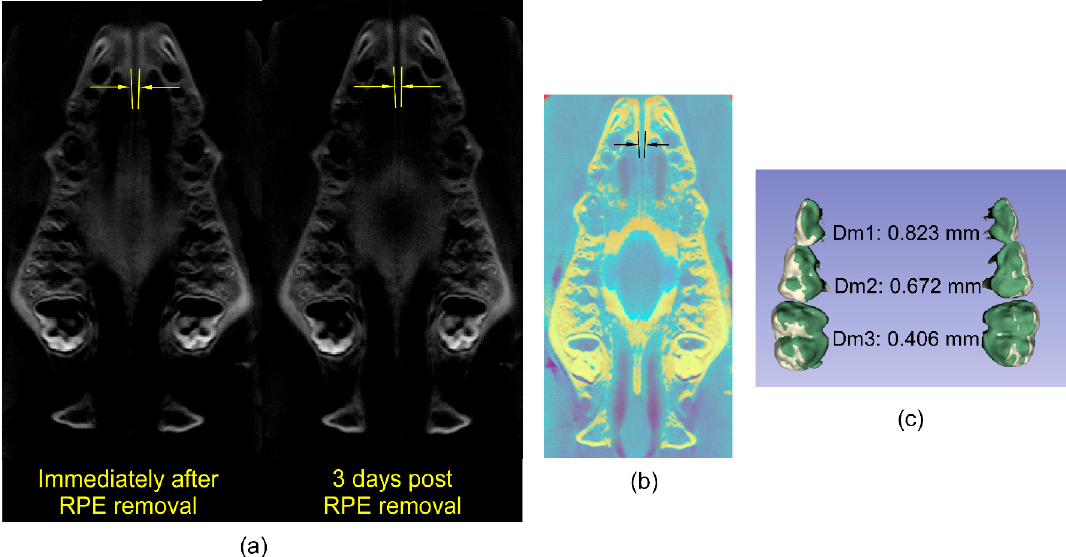
Figure 6. ( a ) Axial slices of CBCT images obtained immediately after RPE removal (left) and after three days of relapse (right) showing sutural separation demarcated by lines and yellow arrows). ( b ) Generalized superimposition of the palate immediately after RPE removal (cyan) and after three days of relapse (yellow) showing minimal changes in midpalatal suture separation. ( c ) Generalized superimposition of the maxillary dentition immediately after RPE removal (white) and after three days of relapse (green) showing the magnitude of relapse at the first (Dm1); second (Dm2) and third (Dm3) molars.